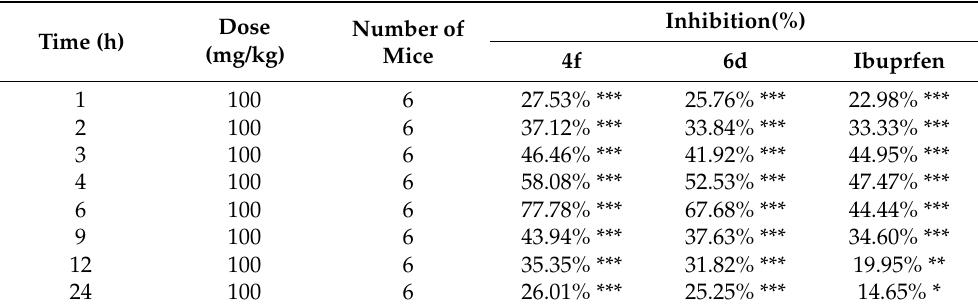
Table 5. In vivo anti-inflammatory activity of compounds 4f and 6d administered orally at different times before xylene application.